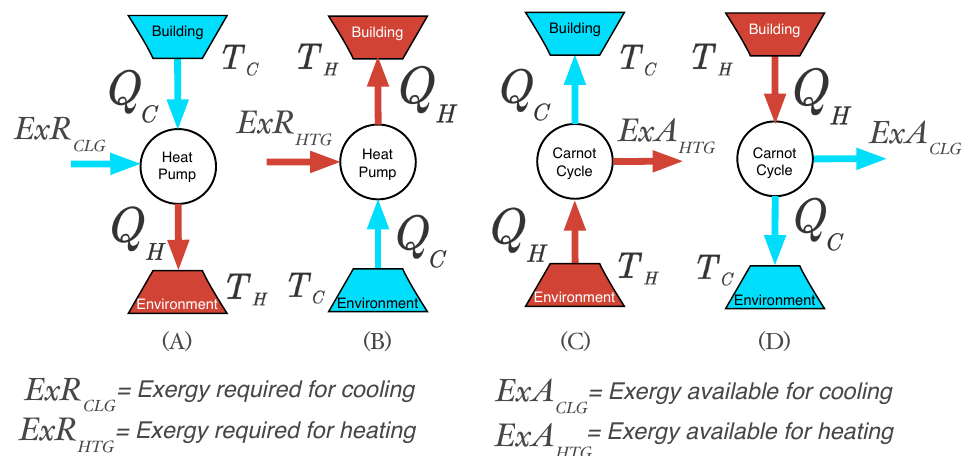
Figure 6. Exergy scenarios: (A) Exergy required for cooling (B) Exergy required for cooling (C) Exergy available for heating (D) Exergy available for cooling.